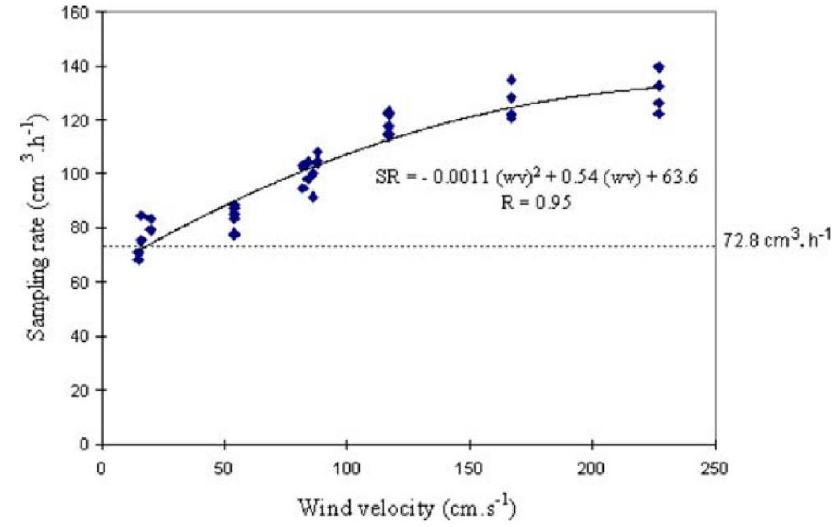
Figure A2. Sampling rate (SR) as a function of wind velocity measured for Palmes PDTs exposed for 24 h in a chamber at 20 ± 1 ◦ C, 50 ± 3% RH and 200 ± 20 µ g m − 3 NO 2 concentration. Figure reproduced from Plaisance et al. [39] with permission of Elsevier.